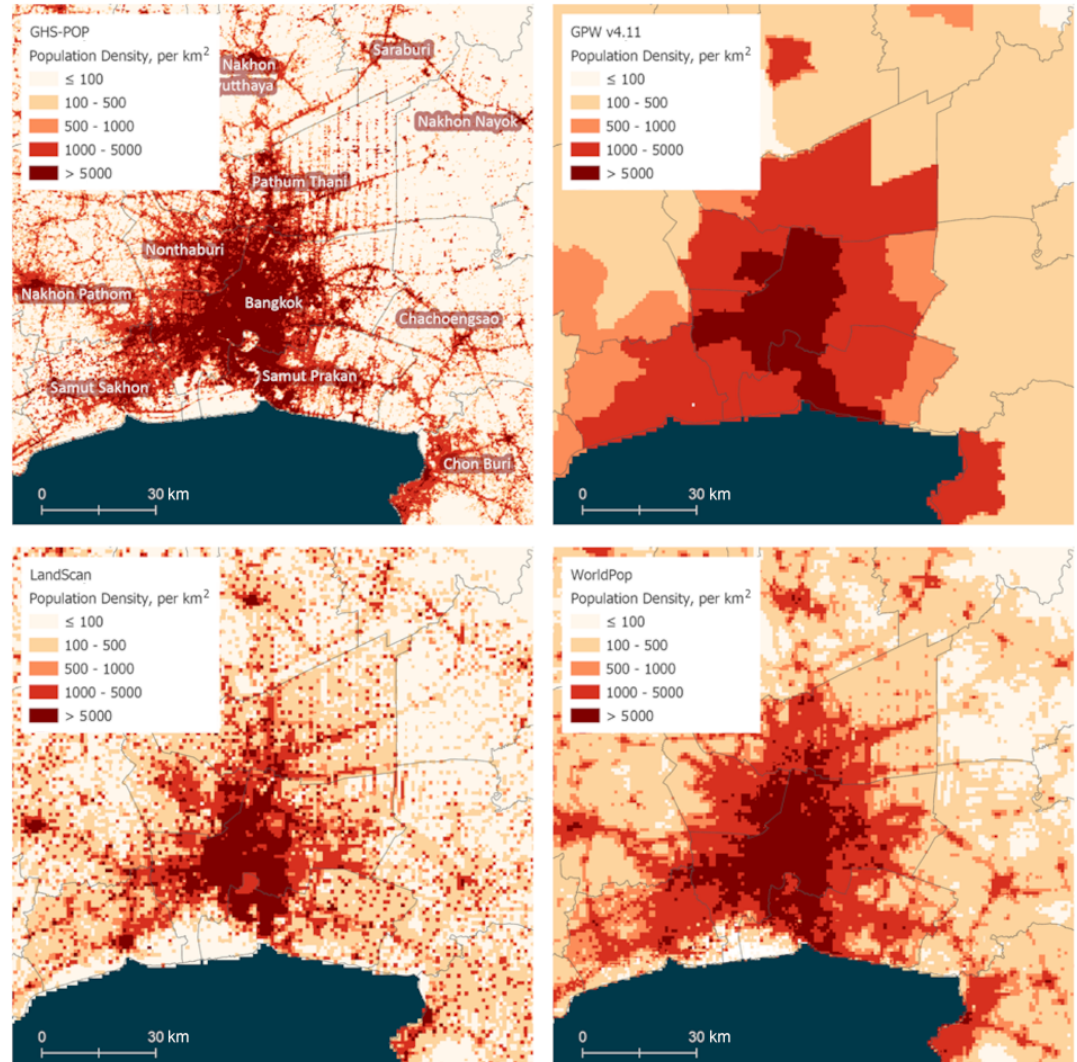
Figure 2. Population source data, Bangkok and surrounding areas, Thailand, 2015. Note that the dark blue indicates ocean, and gray bound- aries indicate first-order administrative boundaries. (These images show the processed 9arcsec data rather than the higher-resolution inputs, given that the resolution differences are hard to detect in this